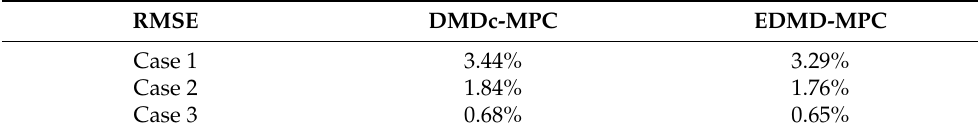
Table 5. RMSEs of tracking errors in different cases.